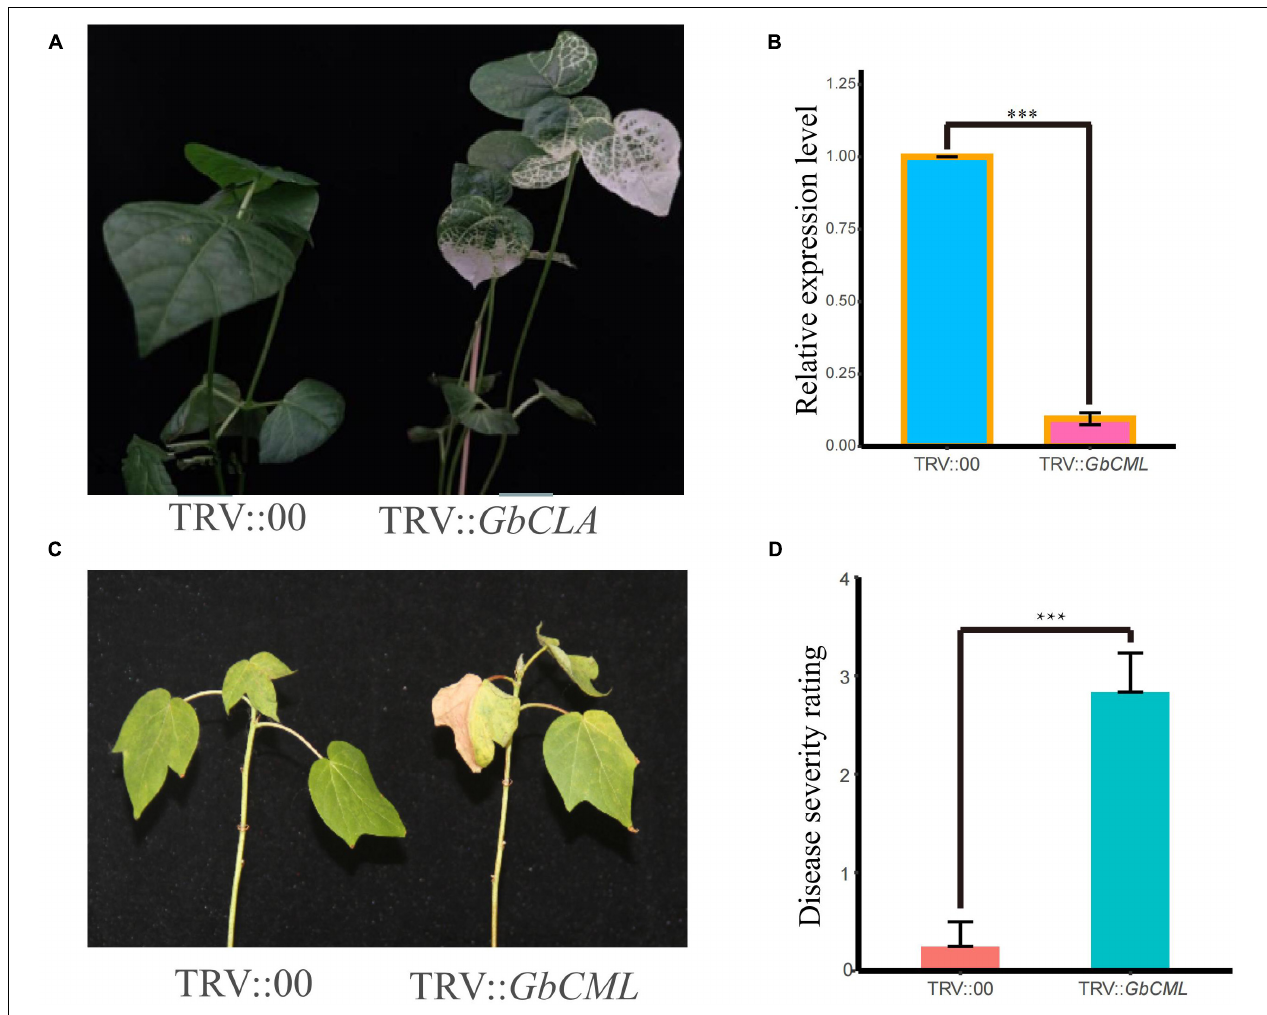
FIGURE 5 | Effects of silencing of GbCML on 06-146 susceptibility to FOV7. Two weeks after infiltration, seedlings were inoculated with FOV7. (A) Seven day-old cotton plants were infiltrated with Agrobacterium carrying TRV: GbCLA . The photographs were taken at 2 weeks after infiltration. (B) qRT-PCR for detection of silencing efficiency. (C) Representative seedlings of control (CK) and silenced plants after inoculation with FOV7 at 20 days post-inoculation (dpi). (D) Responses of control (CK) (TRV:00) and silenced (TRV: GbCML ) plants to the FOV7 at 20 dpi. Disease severity rating (DSR) in CK and silenced plants each with eighteen experimental replicates. The DSR were measured at 20 dpi. Error bars represent the standard deviation of eighteen biological replicates; asterisks indicate statistically significant differences, as determined by t -test ( P <